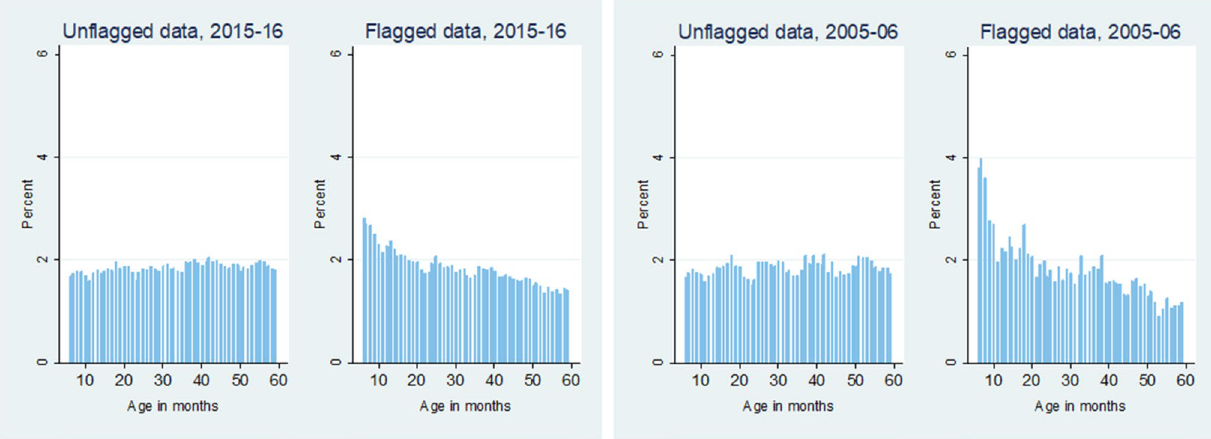
Figure 4. Differences in distribution of ages for flagged and unflagged